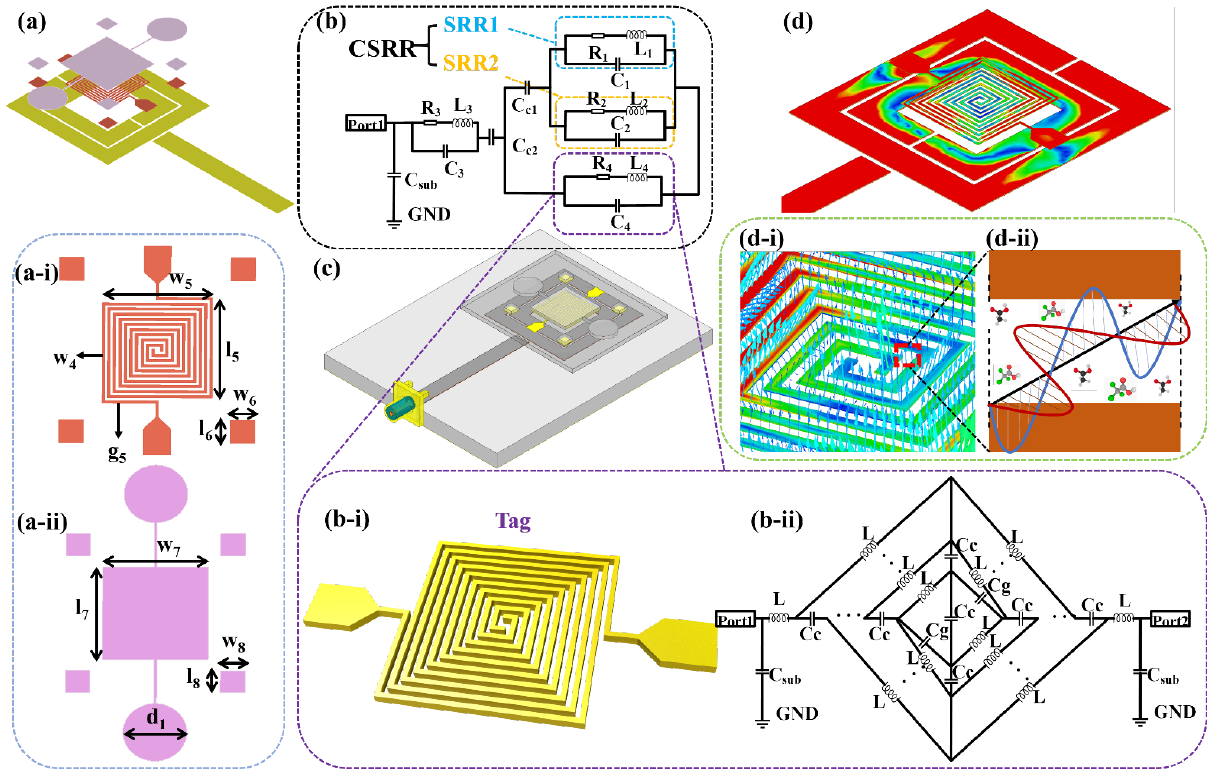
Figure 2. ( a ) Proposed 3D structure of the biosensor and the structure and size of ( a-i ) Tag and ( a-ii ) microchannel, ( b ) the equivalent circuit model of the biosensor, and ( b-i ) Tag structure and its ( b-ii ) equivalent circuit model. ( c ) The model of the proposed biosensor, ( d ) the electric field distribution of Reader and Tag at resonant frequency, and ( d-i ) Tag’s electric field coupling model including ( d-ii ) the schematic diagram of the electromagnetic wave acting inside the metal wire. The electromagnetic wave radiated by the Reader strongly couples with the SSC Tag, and the simulated current density of the biosensor at the resonant frequency is illustrated in Figure 2d. Therefore, the SSC Tag is able to transform a small change in the permittivity caused by the changing of glucose concentration into effective capacitance variations. Accordingly, the CSRR transforms the shift in resonant frequency. The capacitance of SSC is based on the finger width ( WF ), finger length ( LF ), finger gap ( GF ), the gap between electrode and feed line, and feed line width. The 3D schematic, dimension marker, and equivalent circuit of the proposed SSC structure are shown in Figure 2(b-i, a-i, b-ii). The equivalent circuit of the SSC is represented with series/parallel combinations of inductor and capacitor according to design conductive path, coupling, and gap capacitance, respectively. In the presented equivalent structure, L represents inductance, C g represents gap capacitance, and C c represents coupling capacitance. As for conventional SSC models, C g is considered as an essential factor in deciding overall device capacitance. However, after the advancement of micro-fabrication techniques, C c becomes a significant parameter for capacitive variation. The overall circuit capacitance of SSC can also be represented based on an analytical semiempirical equation as [23,24], C SSC = [ ε o ε sub ( 1+ε s 2 ) × K (√ 1 − K 2 ) K(k)